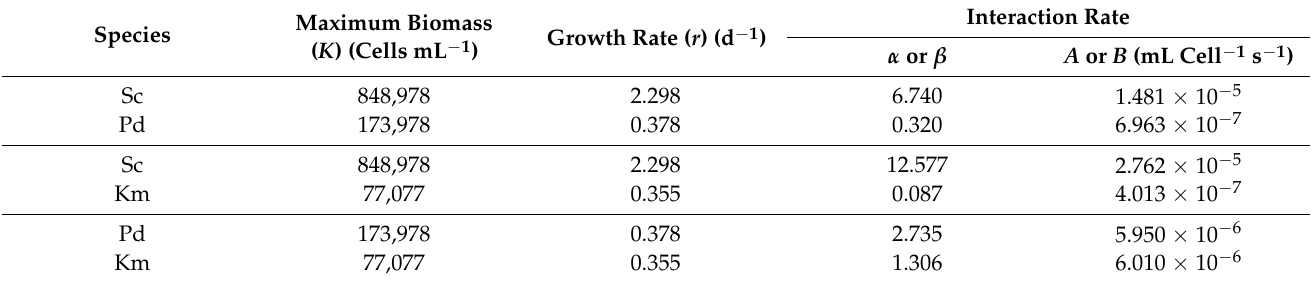
Figure 1. Growth curves of S. costatum and P. donghaiense in mono- and bi-algal cultures under P-sufficient ( A )/deficient ( B ) conditions. The values are the mean ± S.D. ( n = 3), with * represent significant differences ( p < 0.05) between mono-algal and bi-algal cultures. Table 1. Estimates of model parameters for the mono- and bi-algal cultures of S. costatum , P. dong- haiense , and K. mikimotoi under P-sufficient